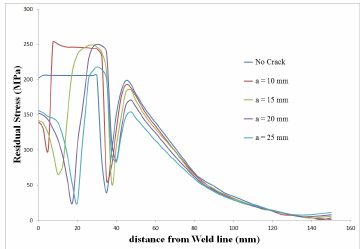
Figure 7. Von Mises stress for different crack